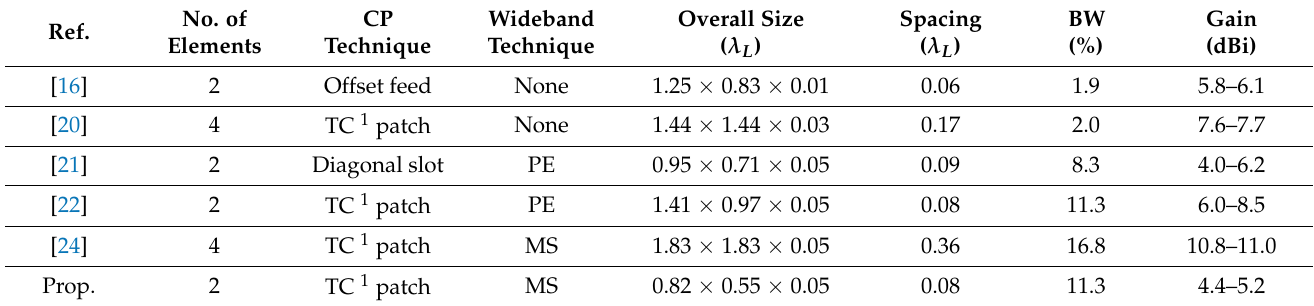
Table 1. Comparison among MIMO CP antennas using microstrip patch